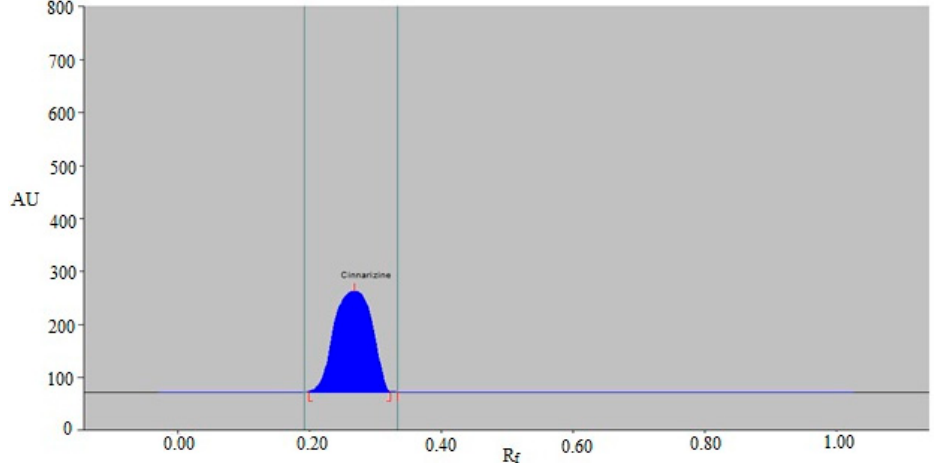
Figure 3. A typical chromatogram of standard CIN for the current approach.